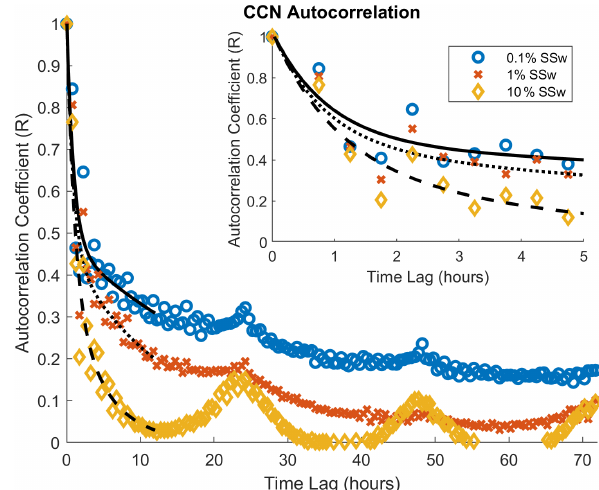
Figure 10. Autocorrelation functions for CCN number concentra- tions at variable SS w . Bi-exponential fits are shown for the first 12h of lag time for each SS w , with solid, dotted, and dashed lines corre- sponding to 0.1%, 1%, and 10% SS w ,